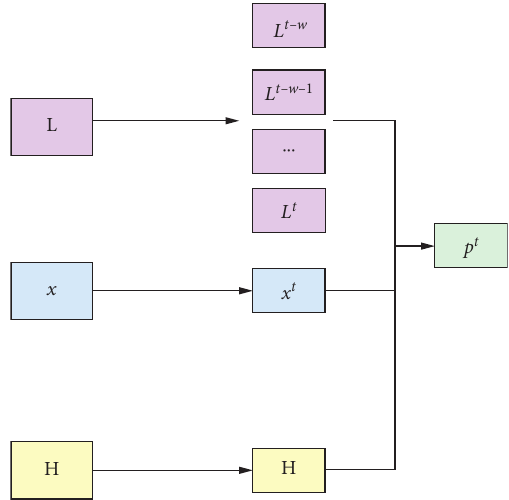
Figure 3: The Attribute augmentation